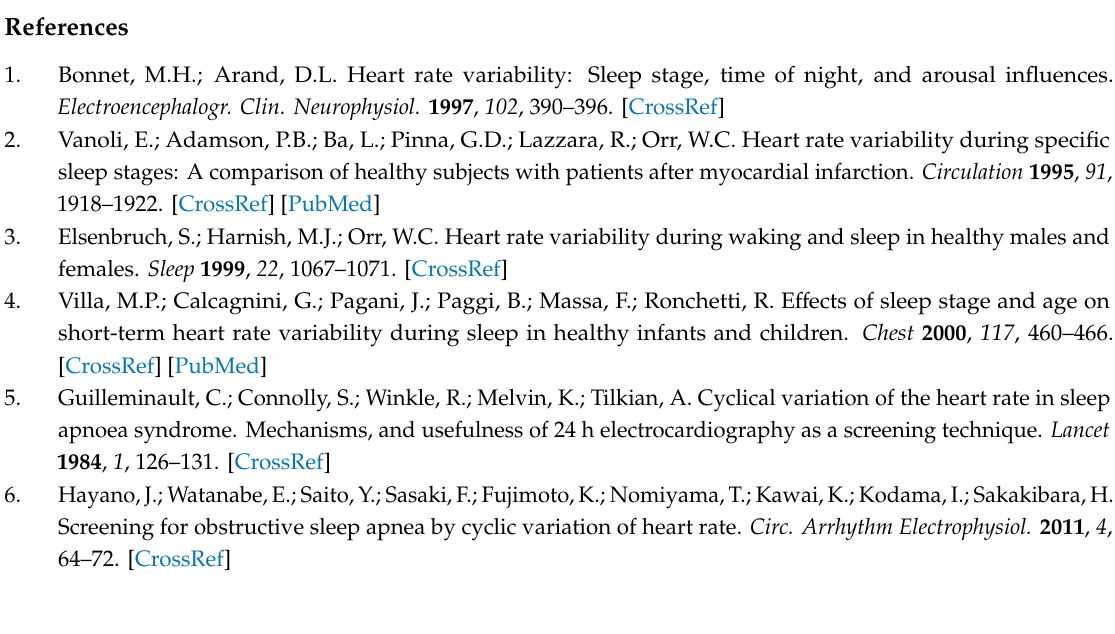
Figure S1: E ff ect of window width for calculating Hsi on the discriminant performance of NREM stage from wake and REM